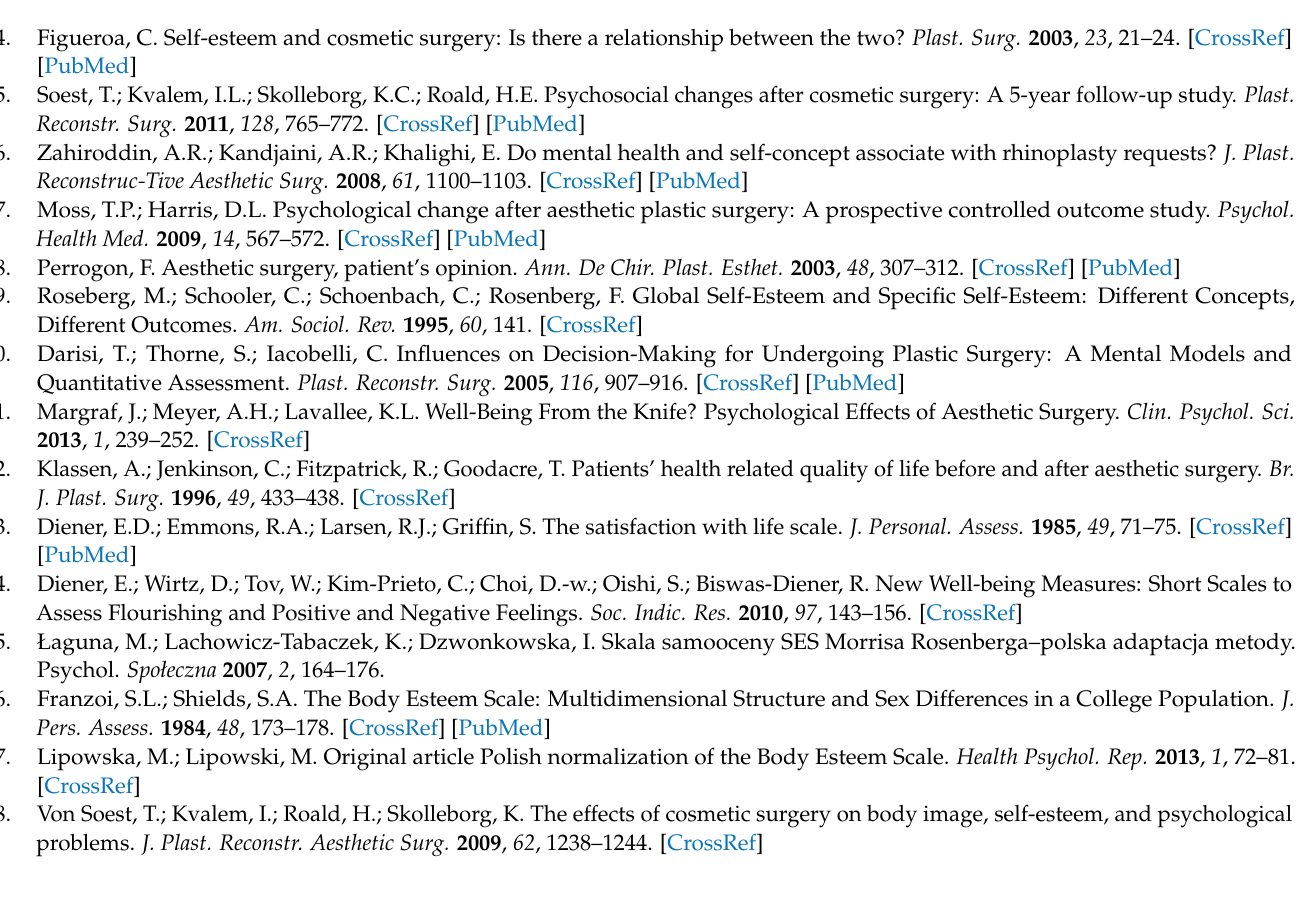
Figueroa, C. Self-esteem and cosmetic surgery: Is there a relationship between the two? Plast. Surg. 2003 , 23 , 21–24.